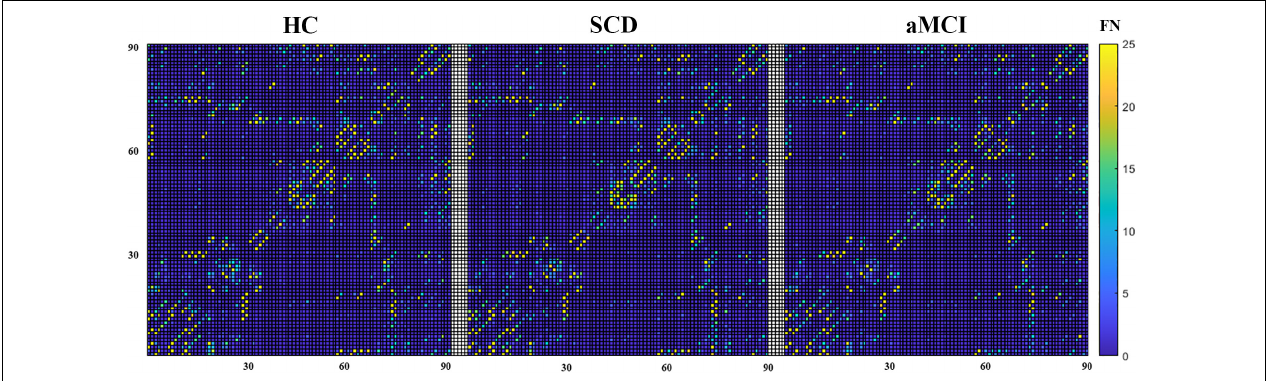
FIGURE 2 | The mean structural network matrix of each group built on the white matter. The horizontal and vertical coordinates represent 90 brain regions in the AAL template. Values in each cell represent the mean FN between two brain areas.